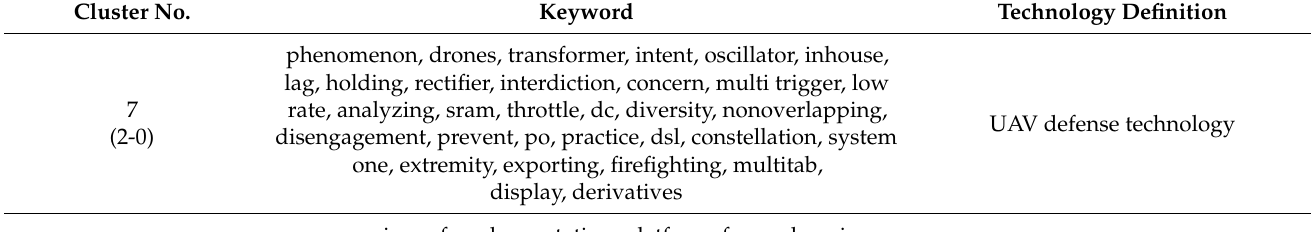
Table 9. Keywords and technology definition for major clusters. Cluster